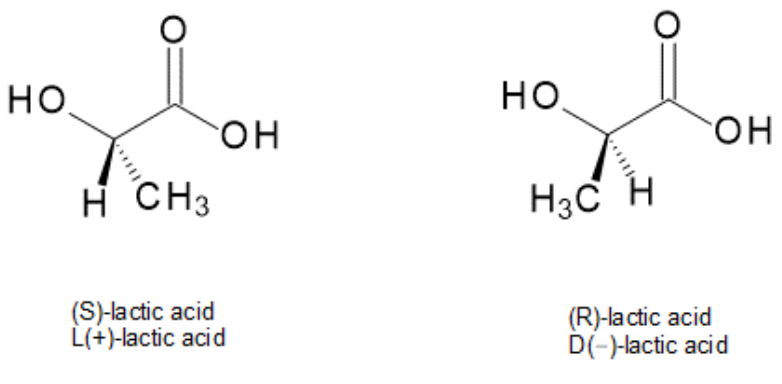
Figure 1. Two lactic acid isomers [13]. Lactic acid can be manufactured on an industrial scale, for example, by the catalytic addition reaction of hydrogen cyanide and acetic aldehyde and then the hydrolysis of the obtained cyanohydrin (Figure